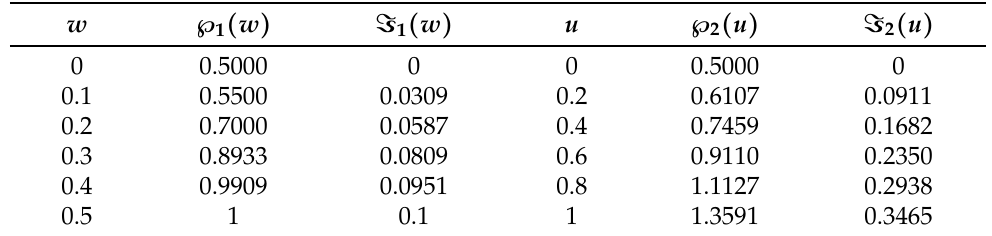
Table 1. Numerical resualts for some functions in Example 1.